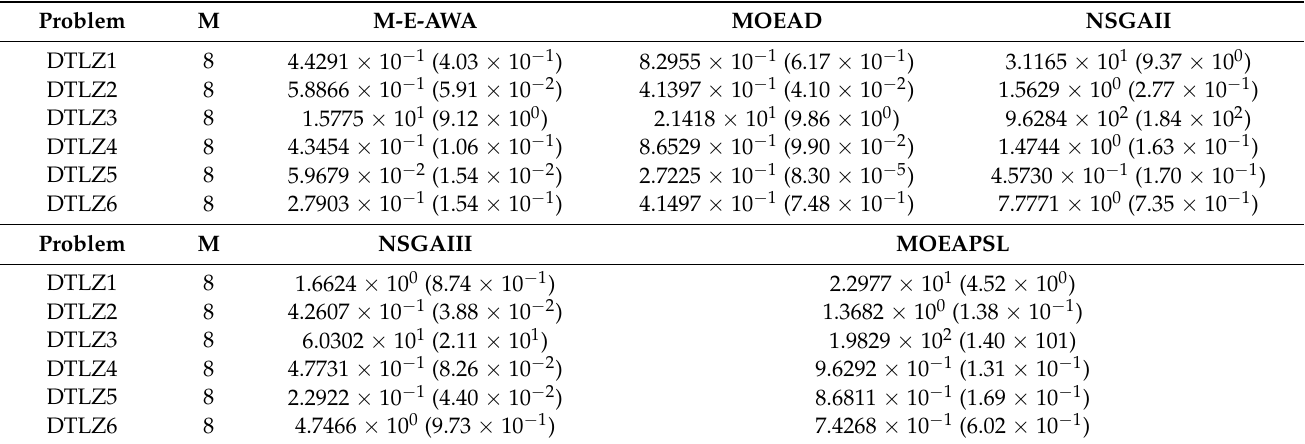
Table 3. Comparison of IGD values between M-E-AWA and contrast algorithms on DTLZ1– DTLZ6(The target number is